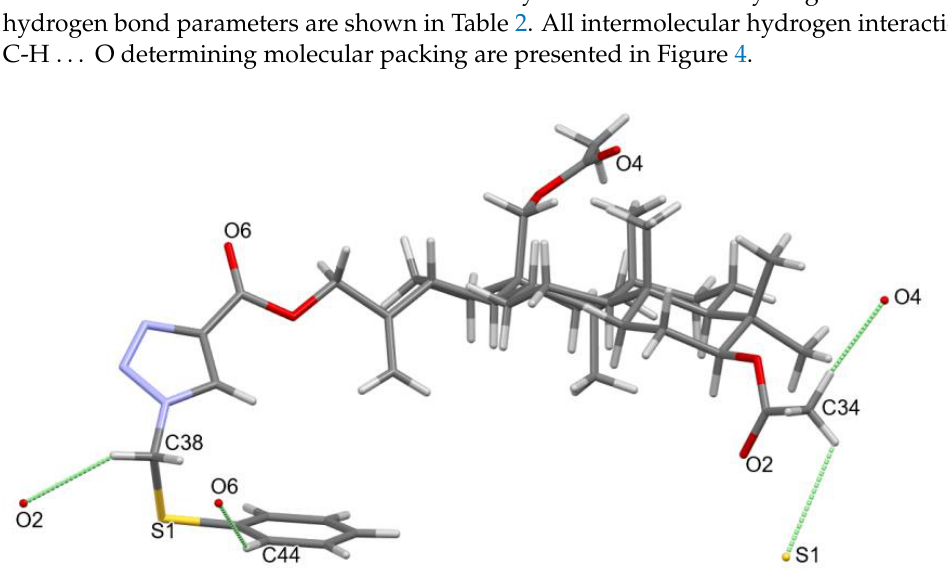
Figure 4. The main weak C-H . . . O hydrogen bonds found in the crystal of 4 . The molecular structure of compound 4 is stabilized by weak intermolecular hydrogen bonds (Table 2; Figure 4). The basic betulin structures are linked to each other in a “head to tail” system through C-H–O bonds formed between atoms C34 and O4 from the next molecule. Molecules connected in this way form a spring-like structure along the a-axis (Figure 5A). Additional stabilization of the crystal structure is provided by the C38-H38–O2, C44-H44–O6, C34-H34C–S1, and C43-H43–N2 bonds (Figure 5B) as well as π – π interactions between the triazole ring and the phenyl substituent (Figure S6, Supplementary Materials). Table 2. Selected weak C-H . . . O hydrogen bonds in 4